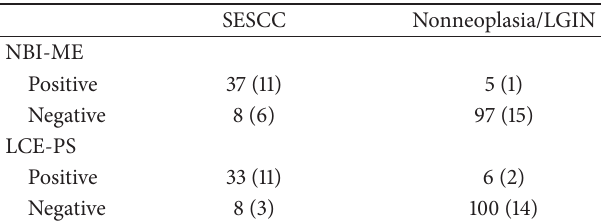
Table 3: Relations between endoscopic diagnosis and final histol- ogy.